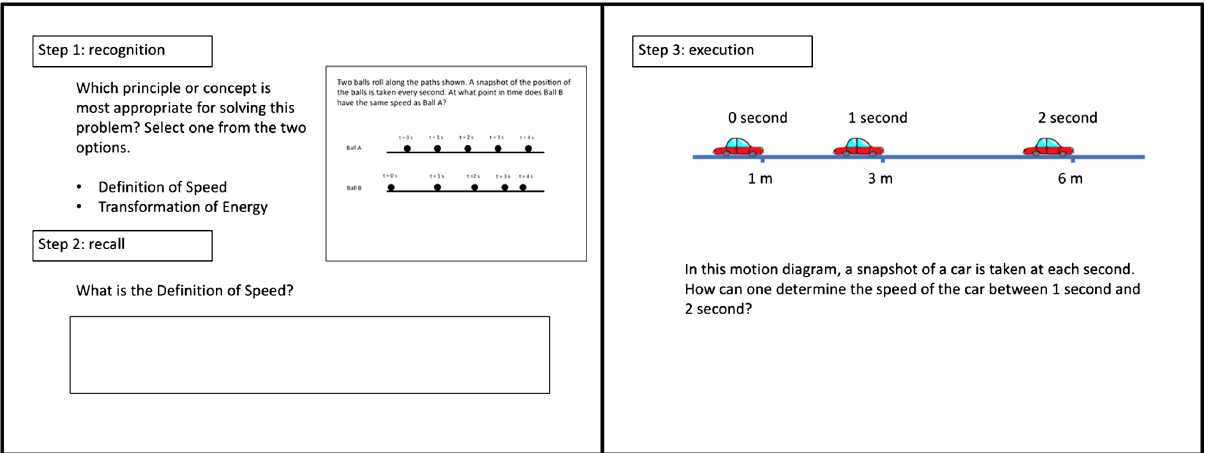
FIG. 4. Retrieval practice for the definition of speed implemented in the framework of Barnett and Ceci